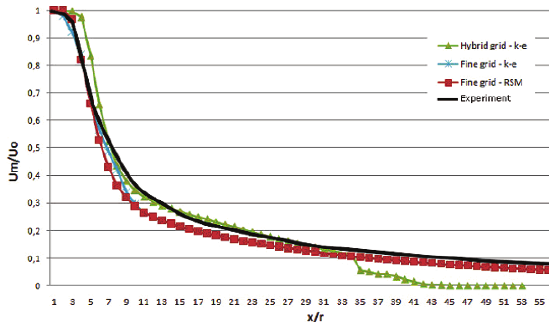
Figure 6. Central jet maximum velocity decay. Comparison between different turbulent models and experimental data: jet-system of in-line ordered 5 circular jets.